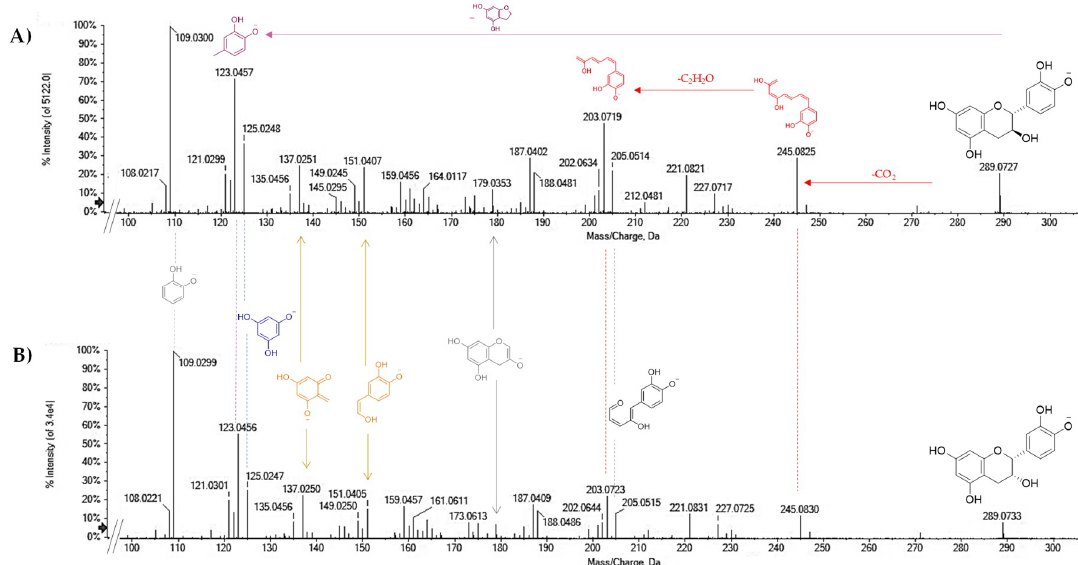
Figure 2. TOF-MS / MS spectra of [M − H] − ion of compounds ( A ) 11 and ( B ) 14 . The structure of the main fragment ions is highlighted. The relative abundance of the ions [M − H-CO 2 ] − and [M − H-CO 2 -C 2 H 2 O] − , as well as of ions from benzofuran-forming fission (BFF, in purple), heterocyclic ring fission (HRF, in blue), and retro Diels–Alder (RDA, in light orange) reactions allowed the geometrical isomers to be distinguished.